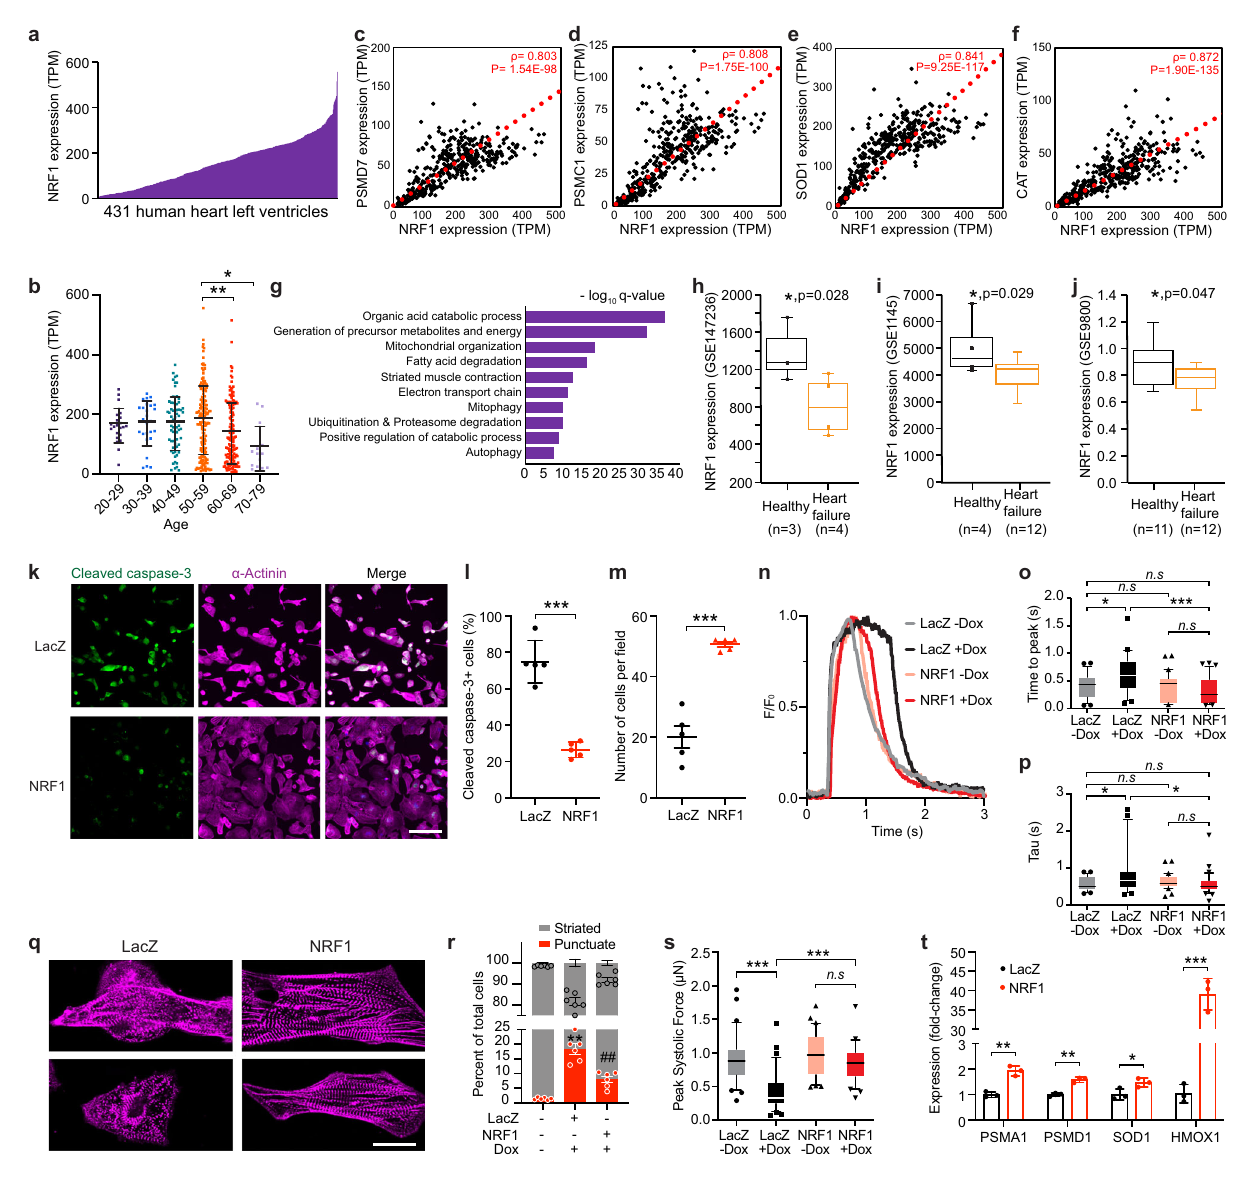
antioxidant response (Supplementary Fig. 13 and Supplementary Data